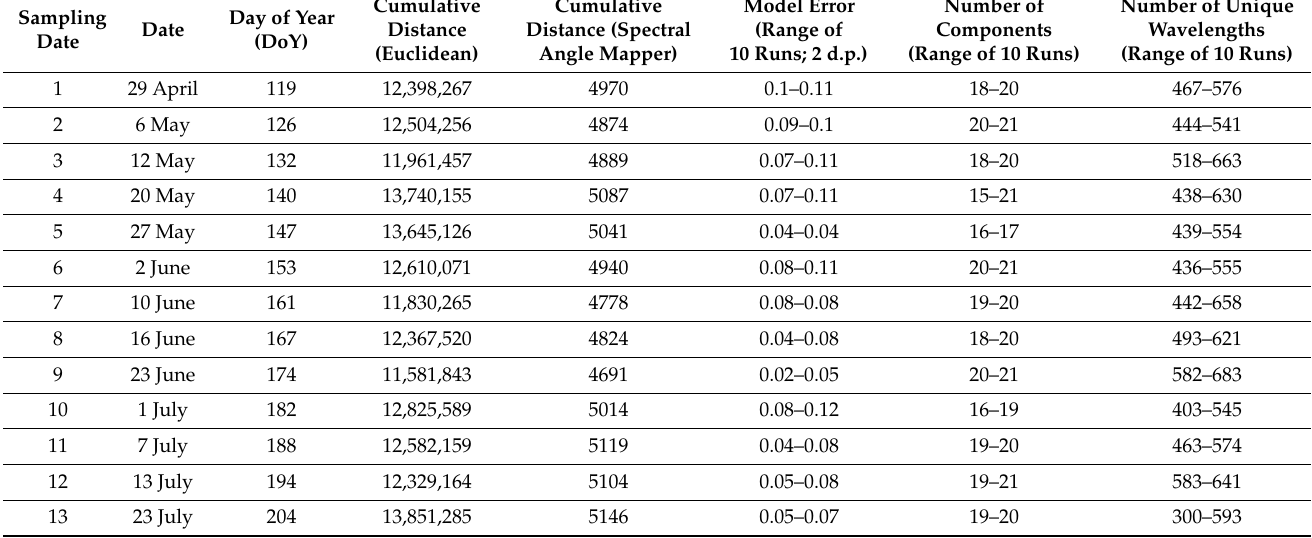
Table 1. A summary of the results of the cumulative spectral distances and sPLS-DA models for